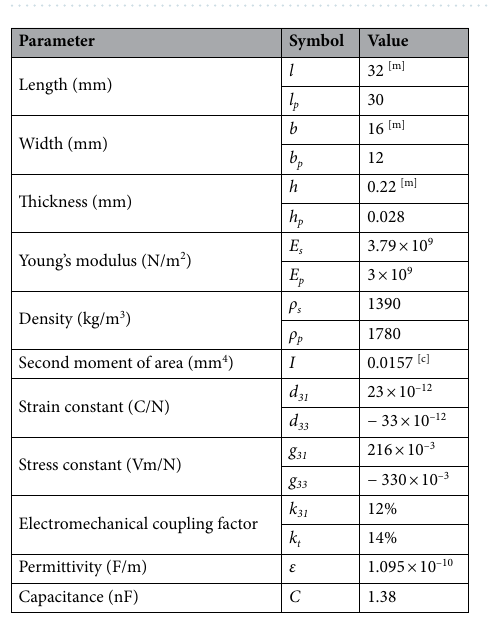
Figure 3. Schematic of the SDOF piezoelectric cantilever beam model subjected to a time varying arbitrary force F ( t ).